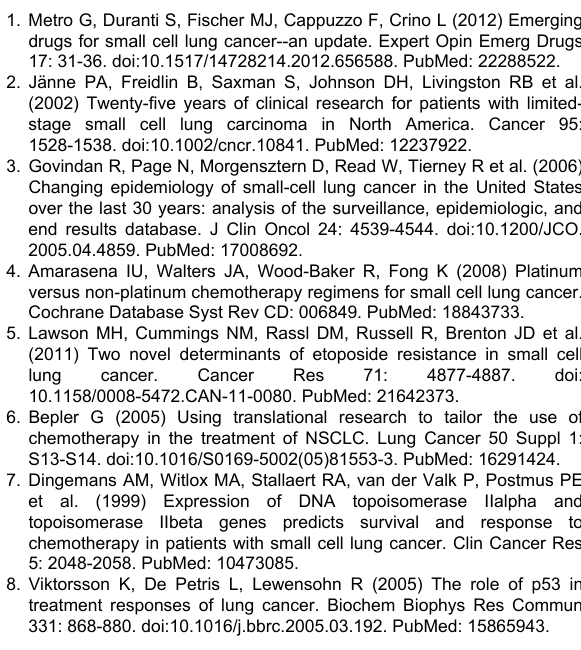
Table S4. LS-SCLC#: Correlation of genes’ expression value and Progression Free Survival and Overall Survival.